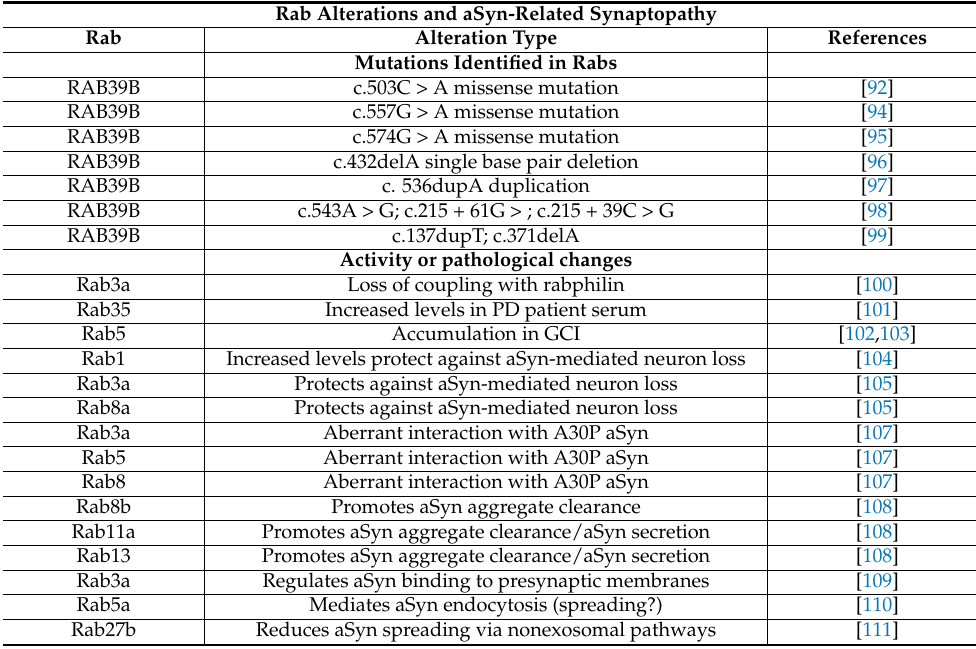
Table 1. Alterations of Rabs in aSyn-related